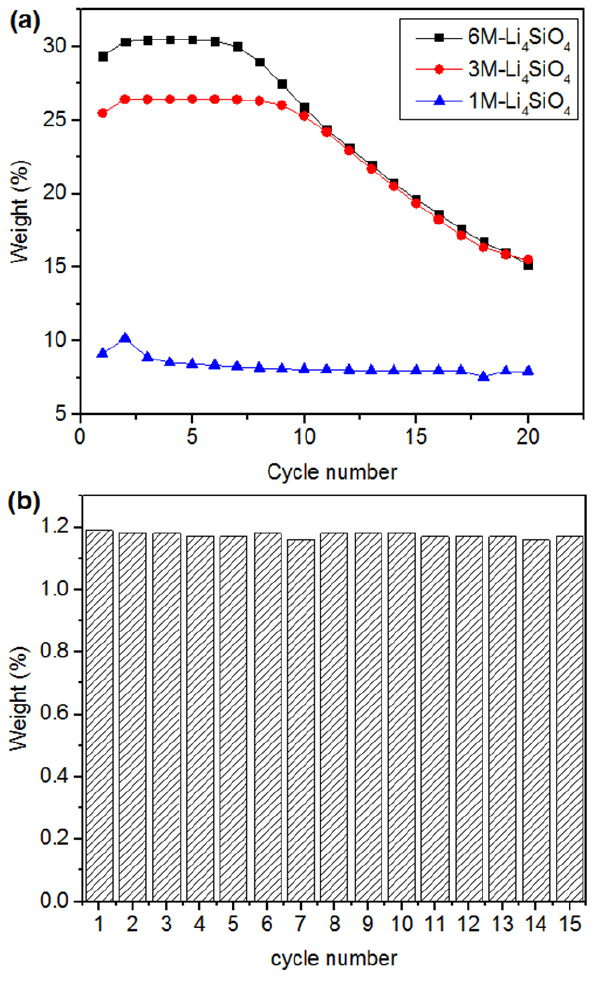
Figure 9. ( a ) CO 2 sorption/desorption cycling performance of Li 4 SiO 4 -(EX-VMT)-4 ( x M) ( x = 1, 3, and 6) samples, and ( b ) CO 2 sorption/desorption cycling performance of the Mg-Al-CO 3 LDH-6M sample.